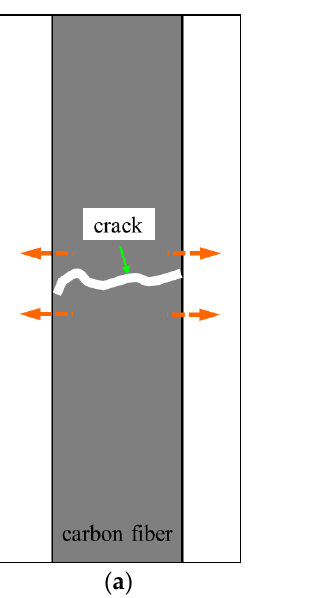
Figure 16. Fracture energy release outlet of interlayer hybrid composites: ( a ) glass fiber sandwiching carbon fiber; ( b ) asymmetric carbon/glass hybrid structure.